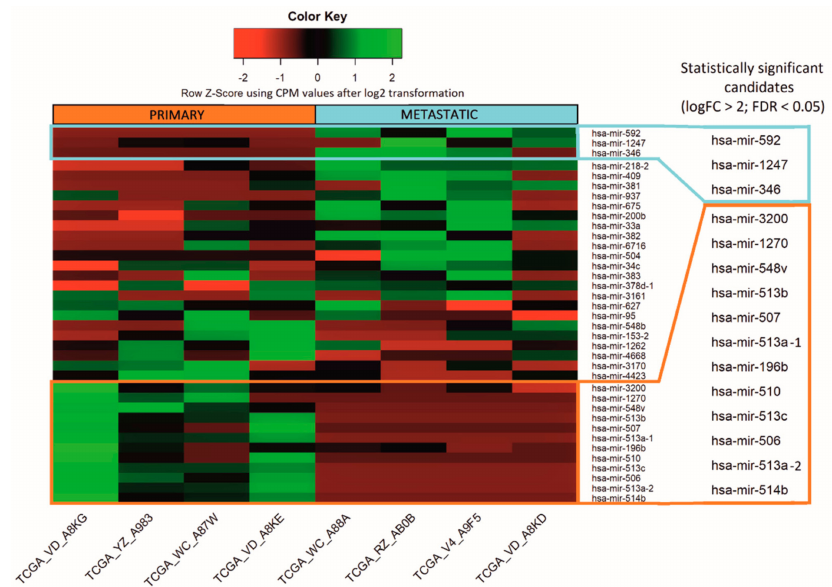
Figure 1. Micro RNA di ff erentially expressed between primary and metastatic uveal melanoma TCGA samples. Altogether, the expression of 37 miRNAs di ff ered between analyzed samples, whereas 15 were considered to be statistically significant (marked with frames), with false discovery rate (FDR) < 0.05. The results are displayed as log2 transformation of normalized CPM